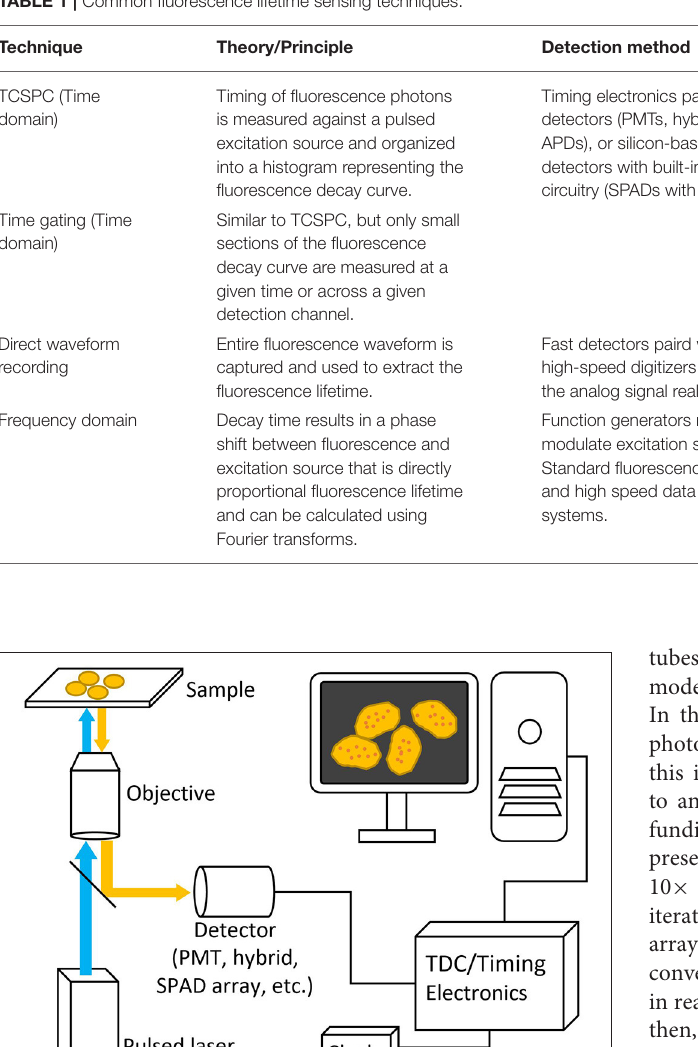
TABLE 1 | Common fluorescence lifetime sensing techniques.